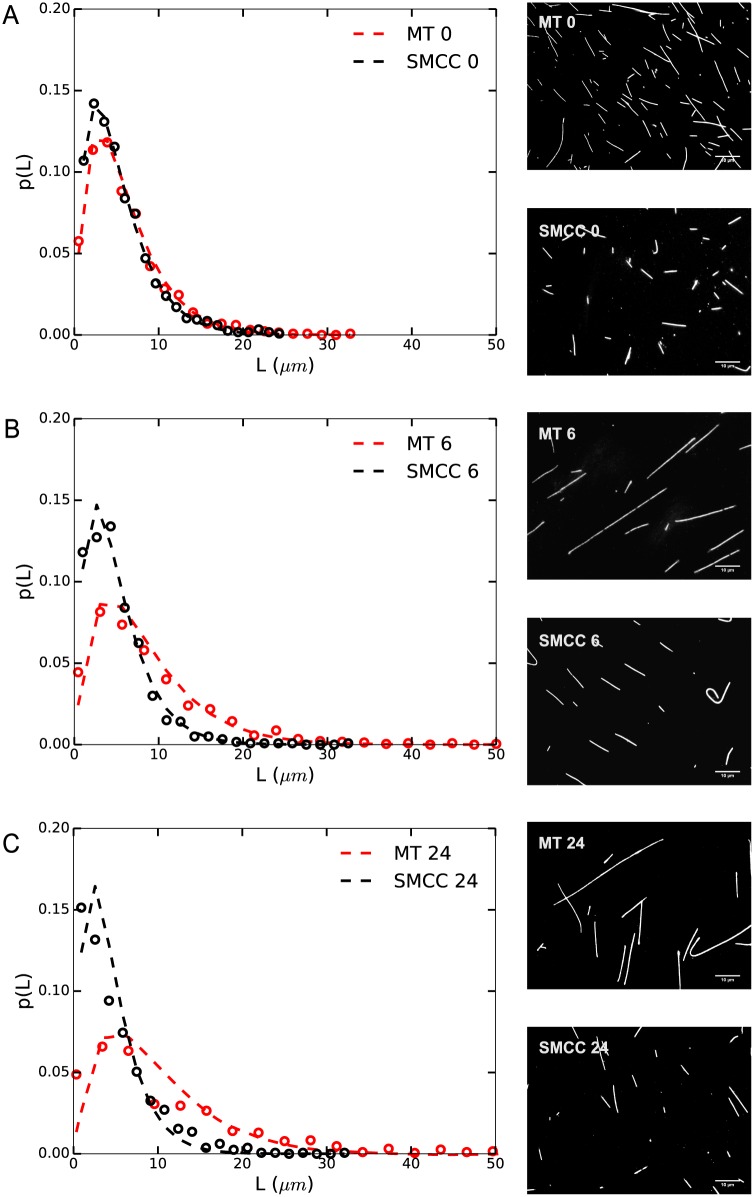
Length distribution of sulfo-SMCC treated and untreated MTs after different incubation times.Length distributions of 2 mg/ml (tubulin) solution of (A) untreated and (B) sulfo-SMCC treated (250 μM) MTs after 0 h, 6 h, and 24 h are shown. Untreated MTs show a significant increase in their mean lengths after 6 h (p < 0.001) and 24 h (p < 0.001) of incubation, in comparison with those measured at 0 h. Sulfo-SMCC treated MTs show a constant mean length, independent of incubation time. Lengths of all samples are distributed exponentially; exponential fits with the normalized probability function a2
Lexp(−aL) are shown as dashed lines. This functional form takes undersampling of short MTs due to the resolution limit into account.